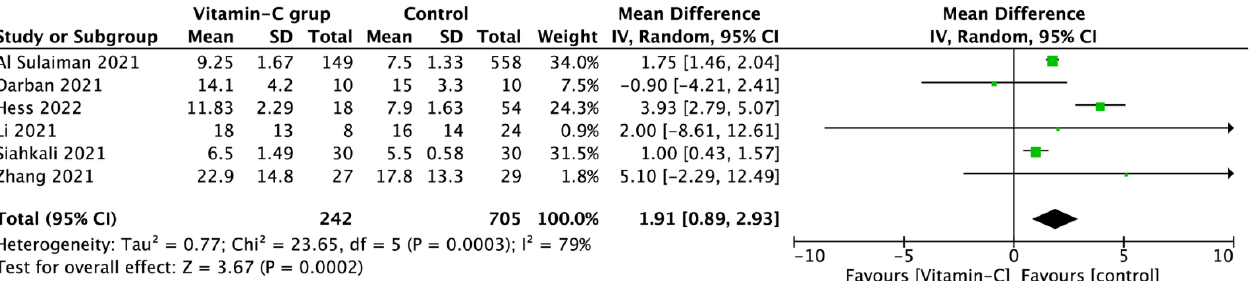
0.34), respectively, Figure 5.